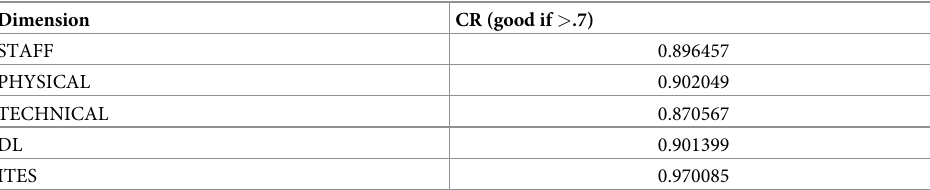
Table 5. Composite reliability.